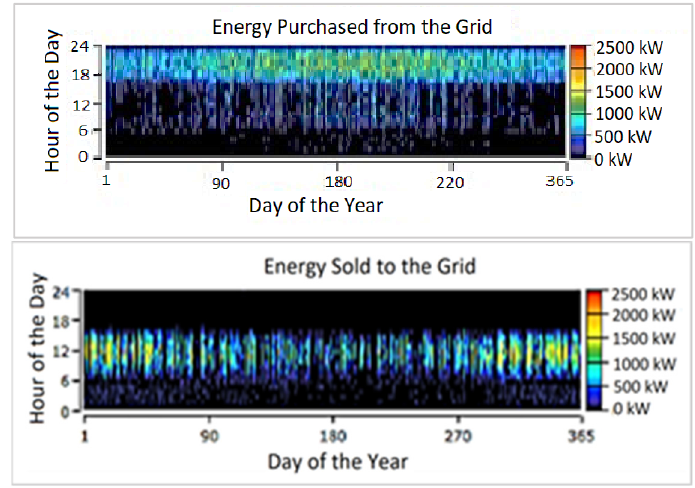
Figure 14. Annually averaged hourly energy density map.